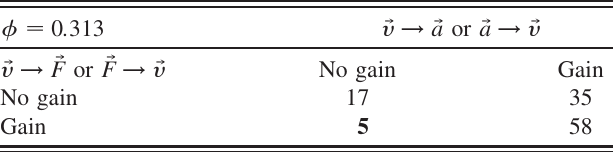
TABLE XII. Summary of hierarchy in gains for v ! F and F ! v with v ! a and a ! v . (cid:2) ¼ 0 : 313